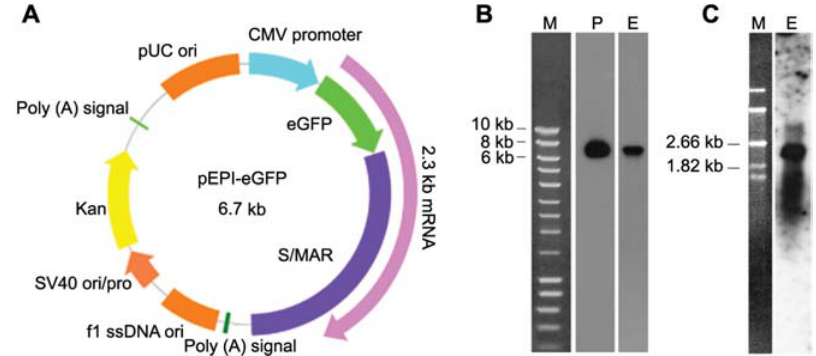
Figure 6 Autonomously replicating vector pEPI. (A) Vector map of pEPI. Transcription of the transgene (eGFP) running into the S/MAR sequence is required for episomal maintenance (pink arrow). Plasmid and eGFP-S/MAR transcript were detected in CHO cells after transfection with pEPI-eGFP using Southern blot (B) and Northern blot (C), respectively. M, ladder; P, plasmid control; E,